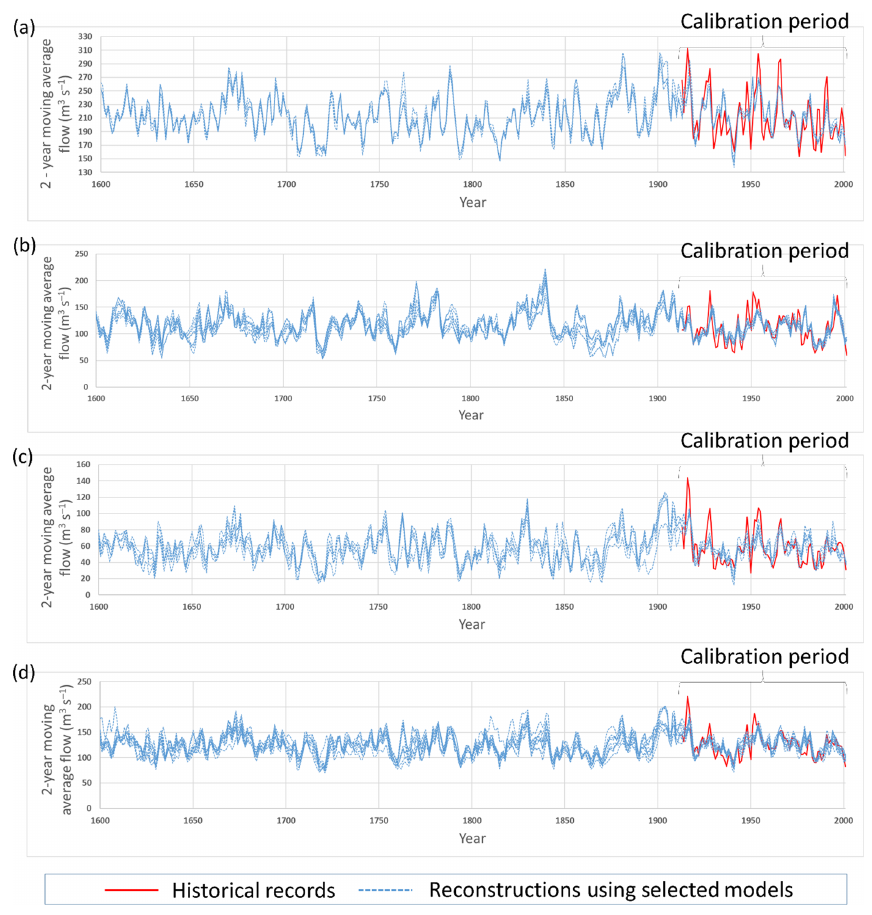
Figure 3. Time series of reconstructed 2-year moving average (biennial) flows in the (a) North Saskatchewan, (b) Oldman, (c) Red Deer and (d) Bow rivers. The shown reconstructed flows for the calibration period are the results of cross-validation.